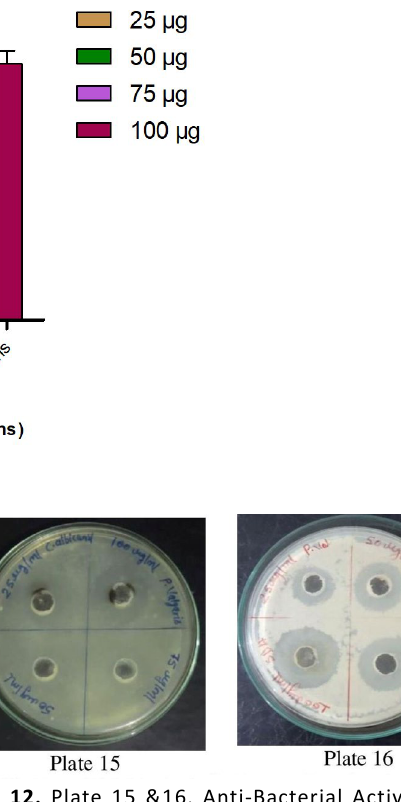
Fig. 12. Plate 15 &16. Anti-Bacterial Activity of Methanolic Extract P. vulgaris against C.